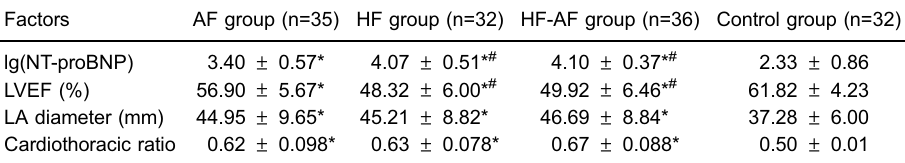
Table 4. Comparisons of cardiac function indices among the groups.